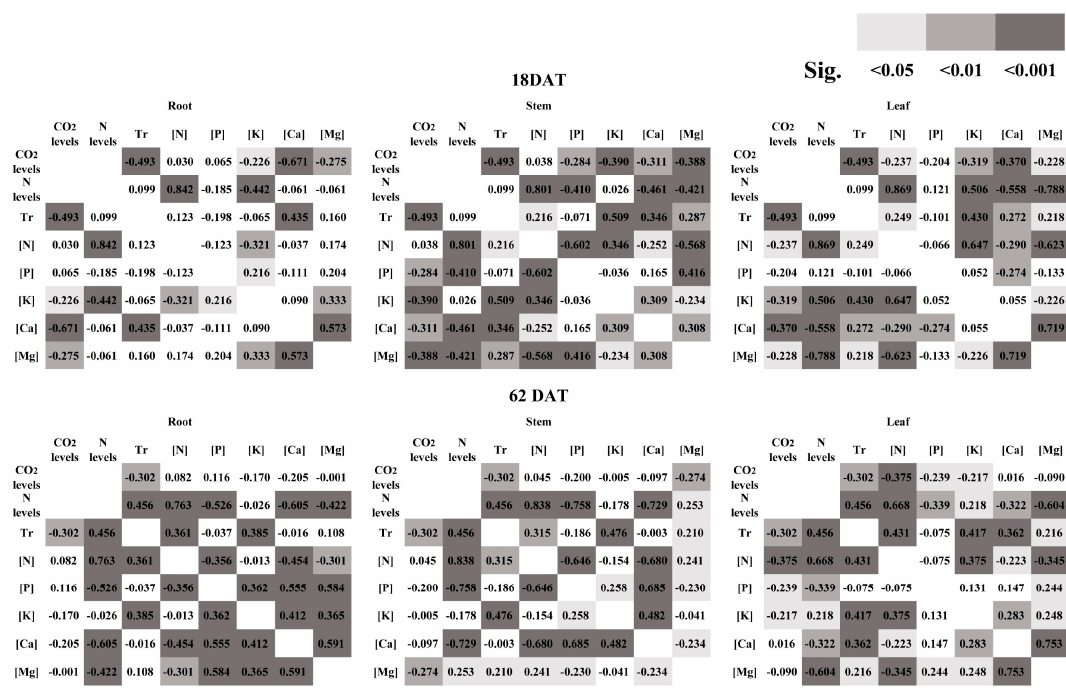
Figure 7. Pearson correlations between [CO 2 ], N supply, transpiration rate and mineral nutrient concentration of cucumber grown under different N and [CO 2 ] levels at two growth stages. Tr: transpiration rate.